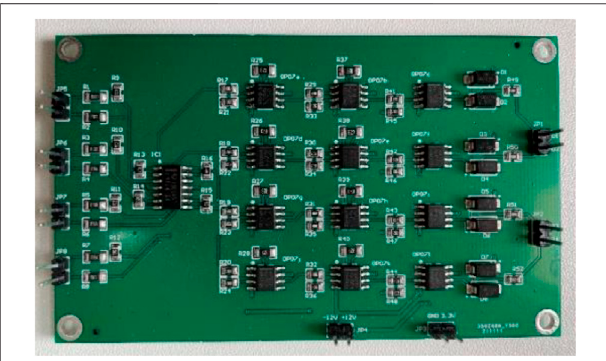
FIGURE 10 | The four-channel current sampling